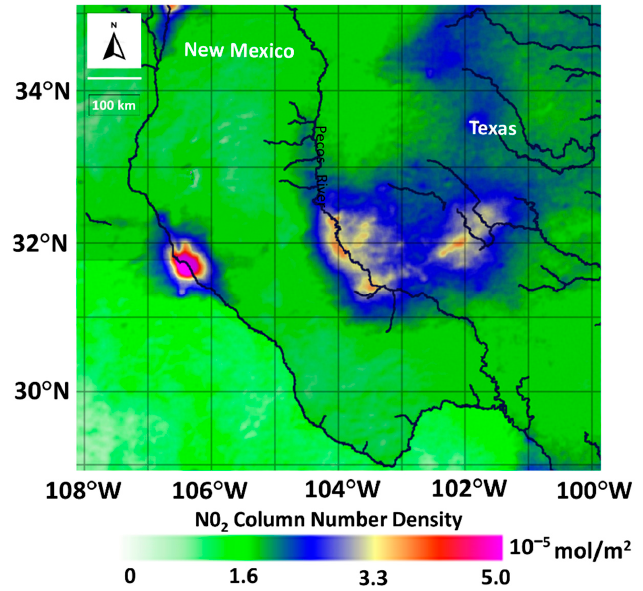
Figure 2. Average TROPOMI nitrogen dioxide tropospheric column number density (NO 2 , in mol/m 2 ) over the Permian Basin region (Figure 1) for the 24-month period 1 December 2018–1 De-